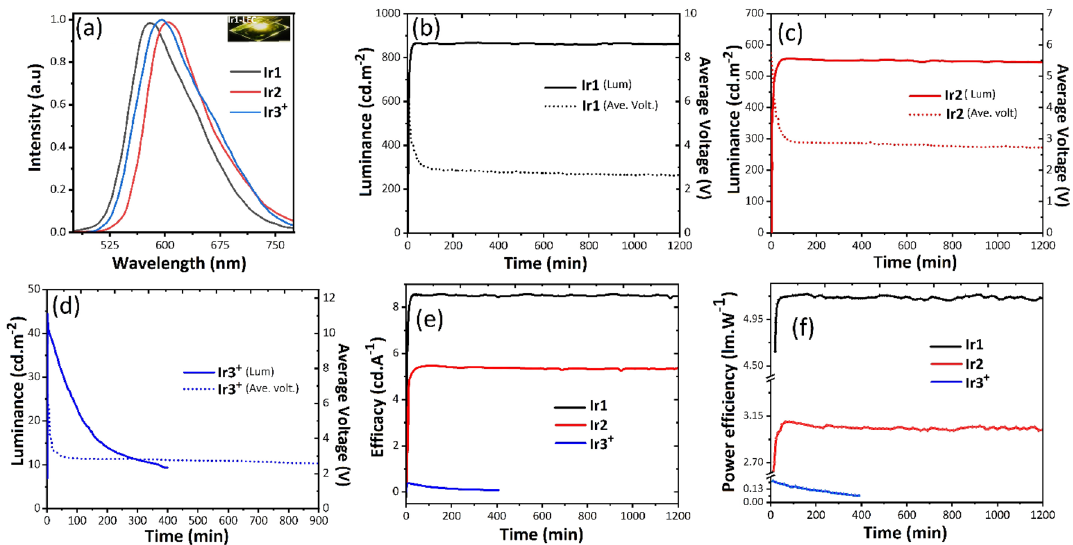
Figure 5. Electroluminescence spectra of LECs Ir1, Ir2 and Ir3 + , inset: Ir1-LEC ( a ). Luminance and average voltage versus time for iTMC-LEC devices, ( b ) iTMC: Ir1, ( c ) iTMC: Ir2, ( d ) iTMC: Ir3 + . ( e ) Efficacy vs time, ( f ) Power efficiency vs time. (All curves were obtained under pulse current driving mode at 100 A.m −2 and duty cycle of